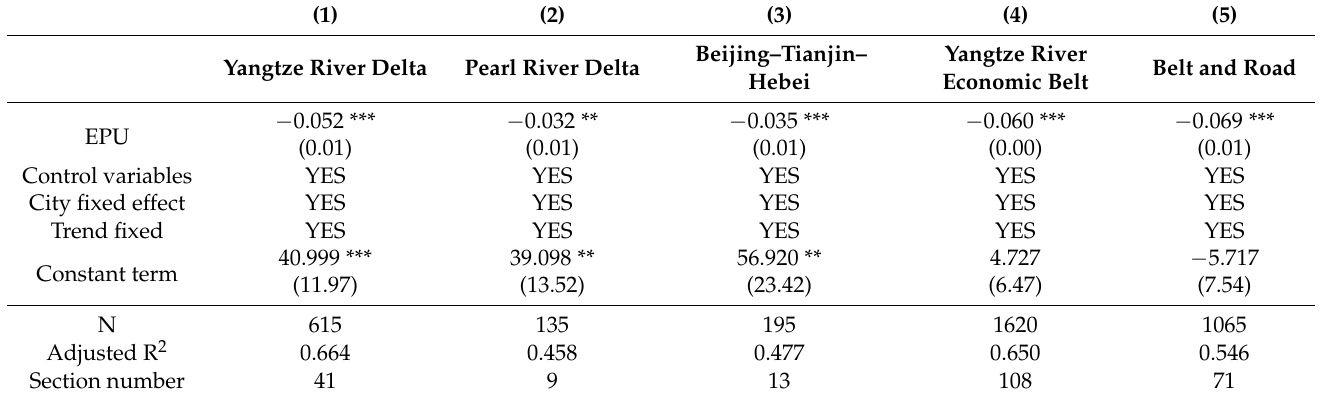
Table 5. Inspection of different city